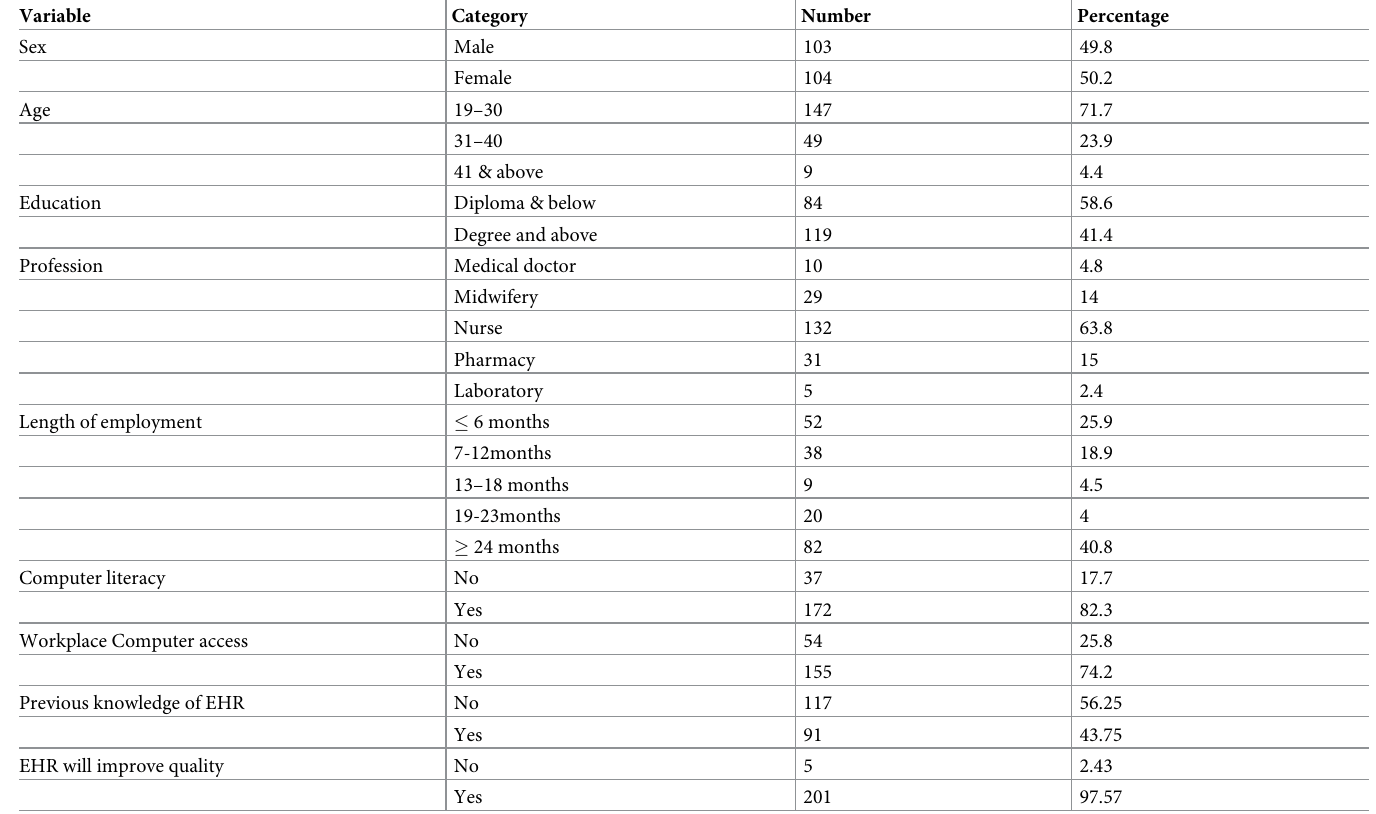
Table 1. Demographic characteristics of respondents.